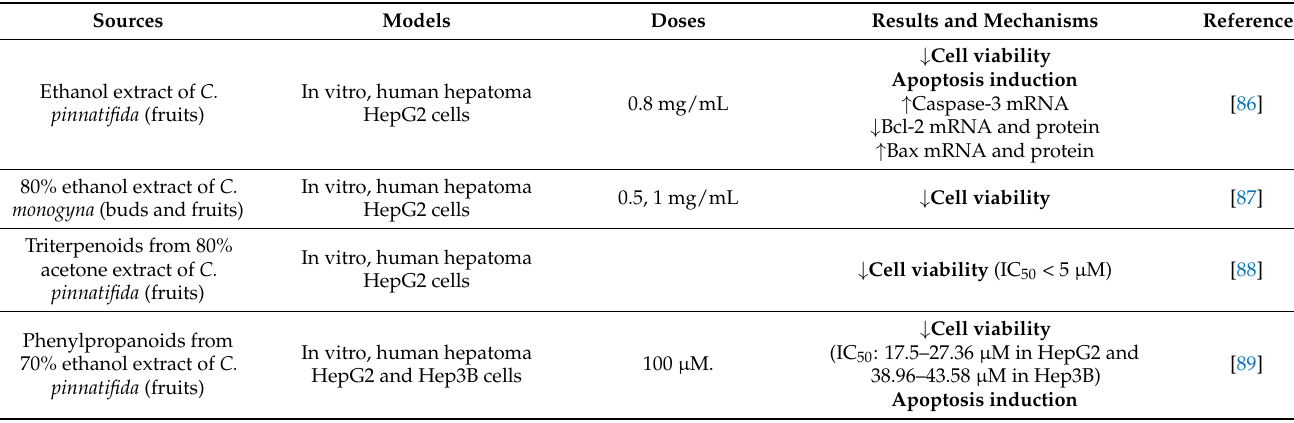
Figure 4. Anticancer effects of hawthorn extract by inhibiting cell viability and cell proliferation in human hepatoma cell lines. Table 4. Anticancer effects and molecular mechanisms of hawthorn extract and its